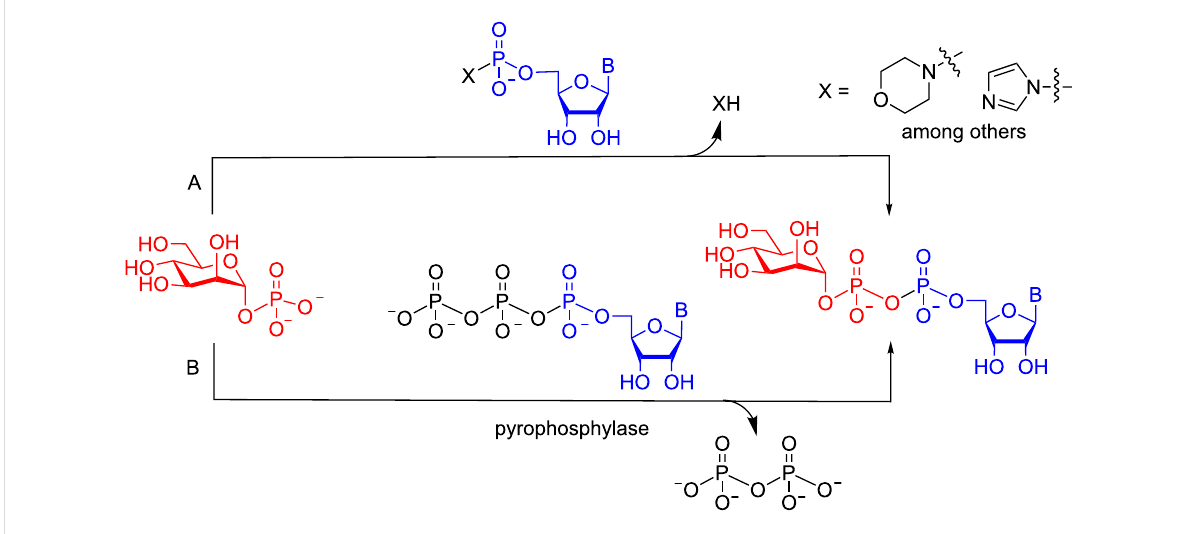
Figure 1: (A) Conventional approach for the chemical synthesis of sugar nucleotides from sugar 1-phosphates; (B) enzymatic conversion of sugar 1-phosphates into sugar nucleotides.